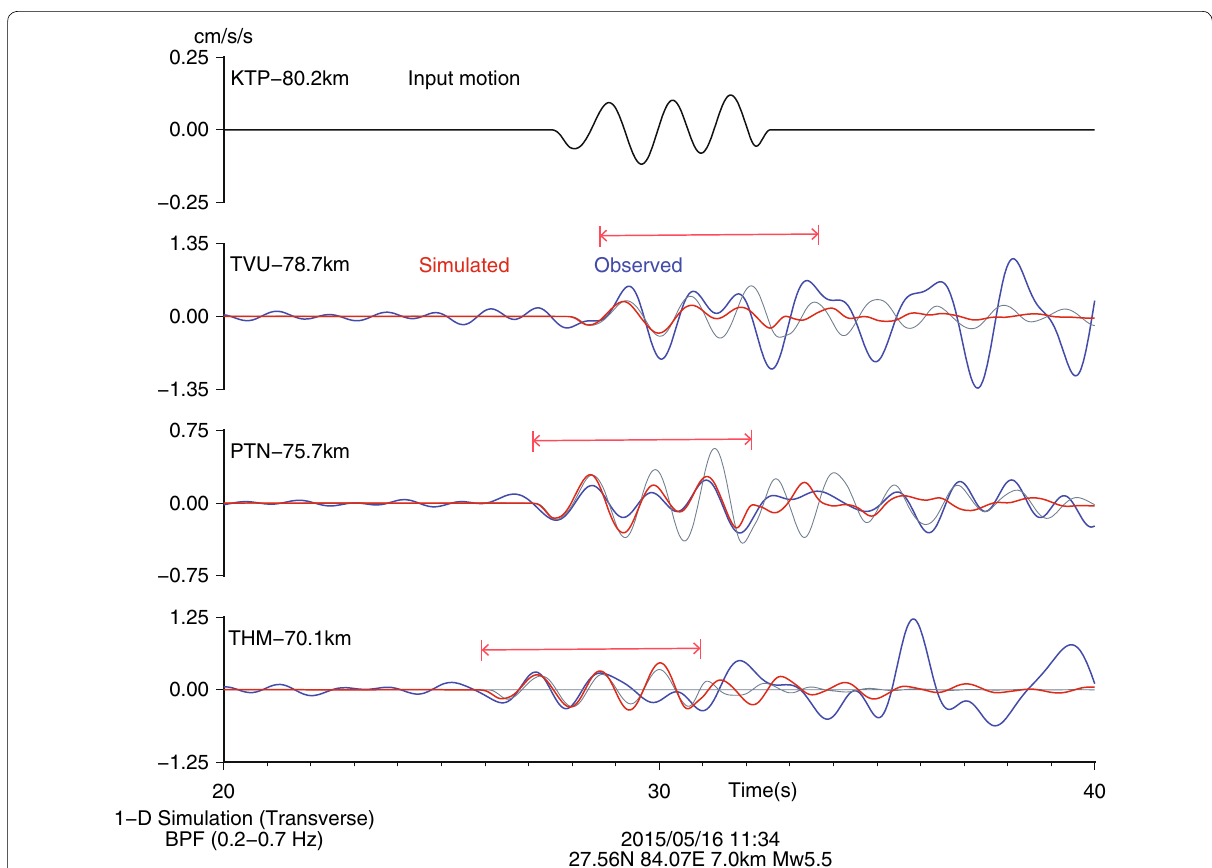
Fig. 11 Comparison of observed and simulated waveforms for the Mw5.5 earthquake. The observed waveform at TVU has a higher amplification than the simulated waveforms. A comparison of results from the initial model ( gray ) and adjusted model ( red ) show that a better agreement is obtained when using the adjusted model. Waveform matching was conducted using trial and error for time windows indicated by the red